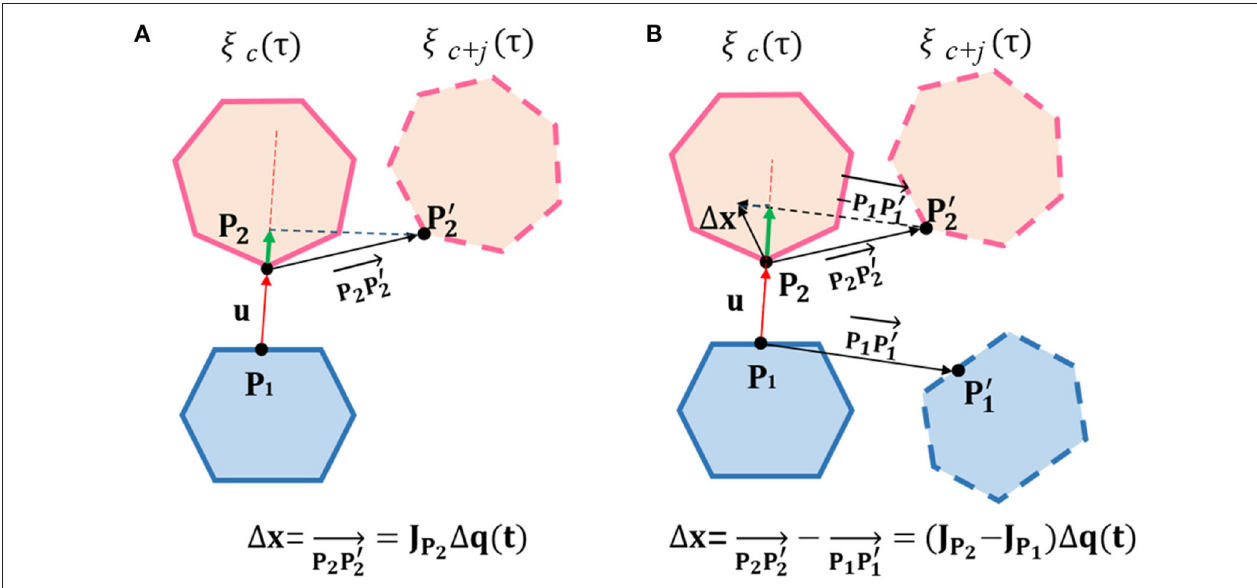
FIGURE 4 | (A) One rigid body is on the robot, while the other is on a static obstacle; (B) Both rigid bodies are on the robot. Diagram for linear constraints calculation.Diagram for linear constraints calculation. ξ c ( τ ) is the state after collision backtracking. ξ c + j ( τ ) is the state after c + j iteration in the future. 1 x is the relative position change between the collision points, and the green line represents 1 x projection on u .